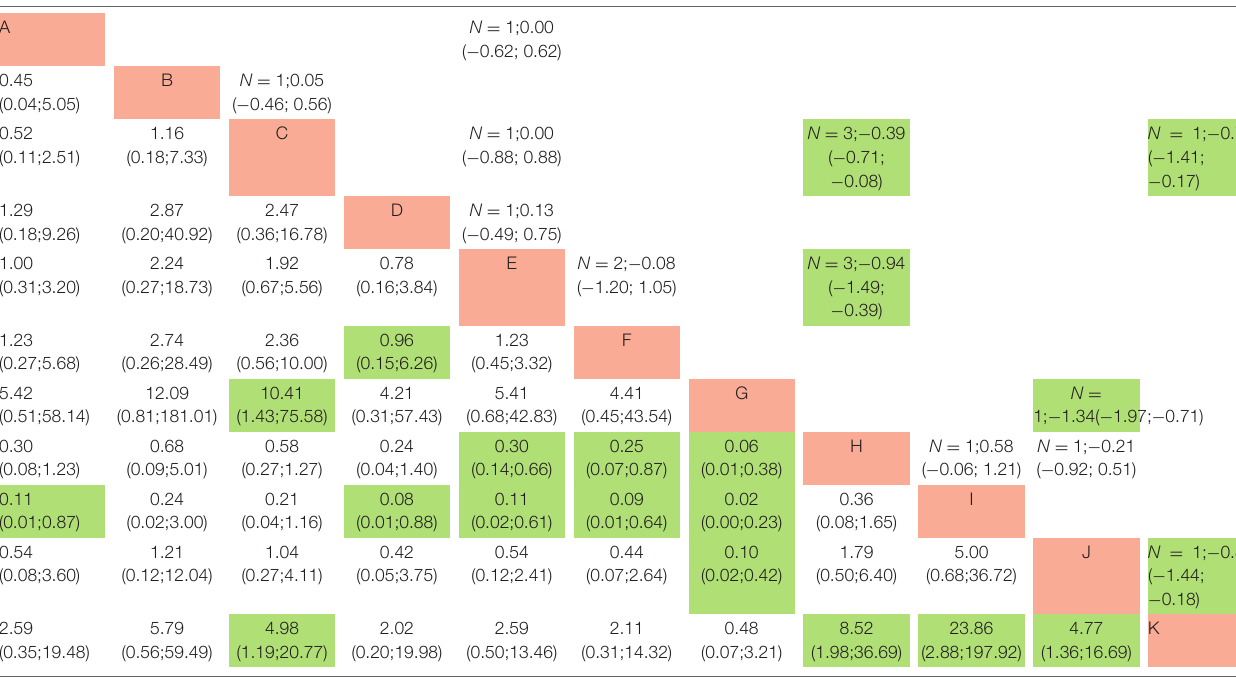
TABLE 5 | Results of treatment comparisons for postoperative